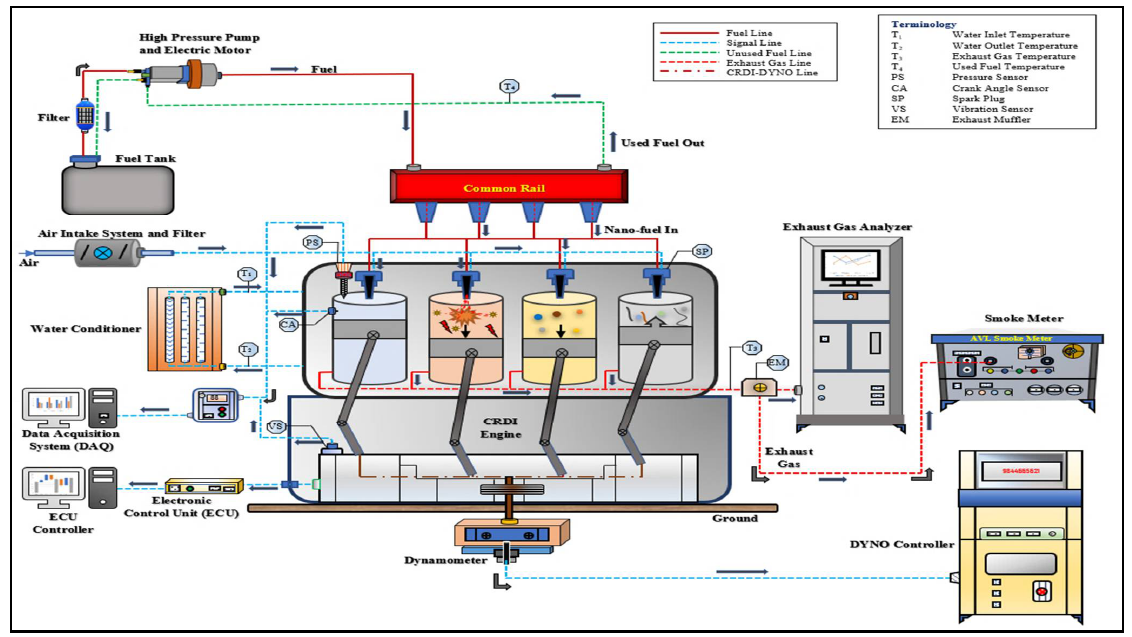
Figure 2. Schematic view of the experimental test rig (adapted from [43], Elsevier, Amsterdam, The Netherlands, 2021).